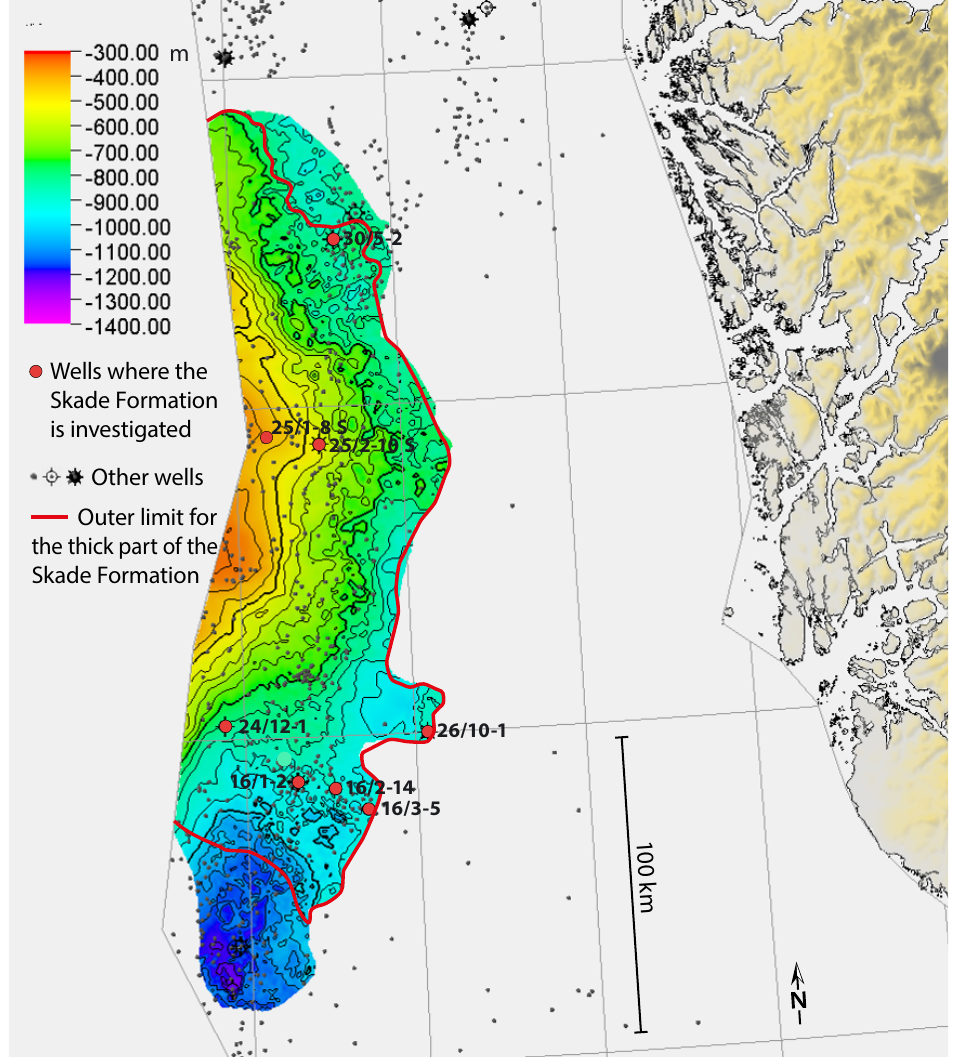
Figure 41. Map showing the extent of the Skade Formation and the depth to the top of the formation (npd.no/facts).